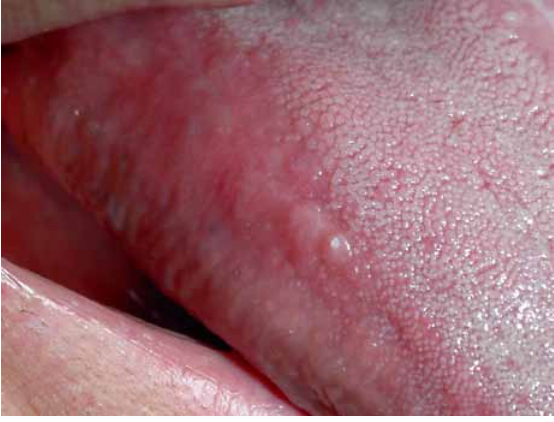
Figure 4. Dorsal part of the tongue after healing. Condition after 3 years from